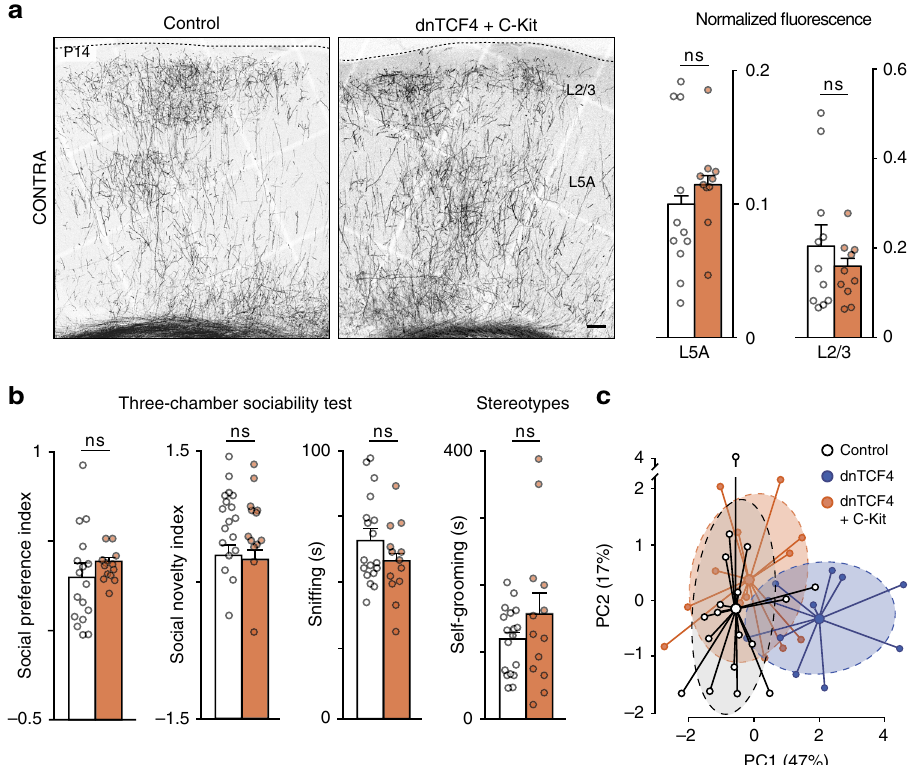
Fig. 7 Correcting CPN migration delay rescues the circuit and behavior phenotype. a Restored migration by C-Kit overexpression rescues axon arborization. Graphs show the average regional intensity in L5A and L2/3, n = 11 and 10 brains (Control and dnTCF4 + C-Kit, respectively), Mann – Whitney, P = 0.1971 for L5A and P = 0.7564 for L2/3. b Sociability, interaction (snif fi ng), and tendency for repetitive movements (self-grooming) are rescued by C-Kit overexpression; n = 18 and 13 animals (Control and dnTCF4 + C-Kit, respectively), Mann – Whitney, P = 0.1324 for social preference, P = 0.7004 for social novelty, P = 0.3167 for snif fi ng and P = 0.5736 for self-grooming. c PC analysis plots of autistic-like